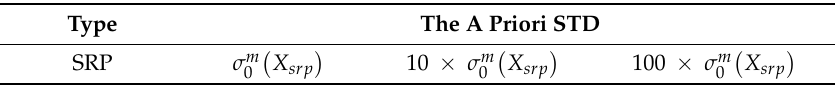
Table 11. The experiment scheme of the convergence analysis after the orbit maneuver.